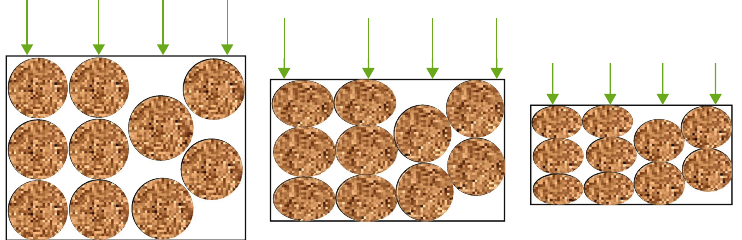
Figure 12: Schematic diagram of pore throat